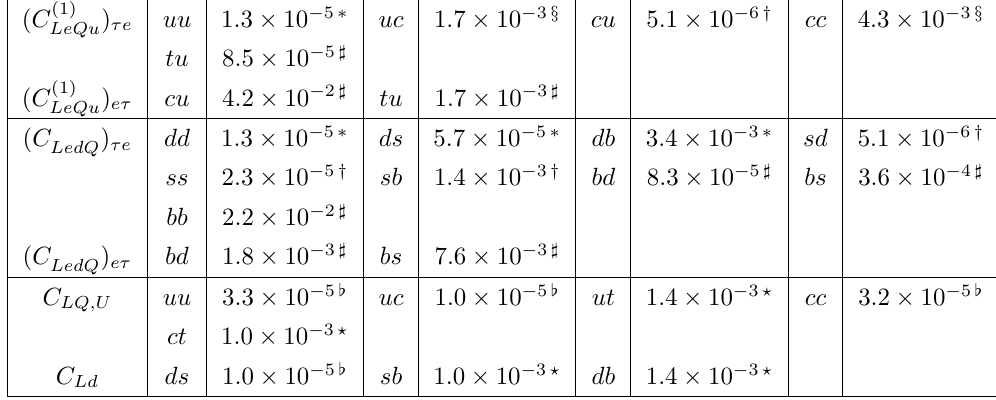
Table 15 . 90% C.L. limits from charged-current leptonic decays and neutrino processes, assuming a single operator is turned on at the scale Λ = 1 TeV. The superscripts denote limits from decay ratios ( ∗ ) R , ( † ) R , ( § ) R e and R e , and ( ] ) R e and R µ , and from decay modes SM SM π /R K /R π K D D s B B ( [ ) K → πνν and ( ? ) B → ( K, π ) νν . Purely leptonic decays of pseudoscalar mesons